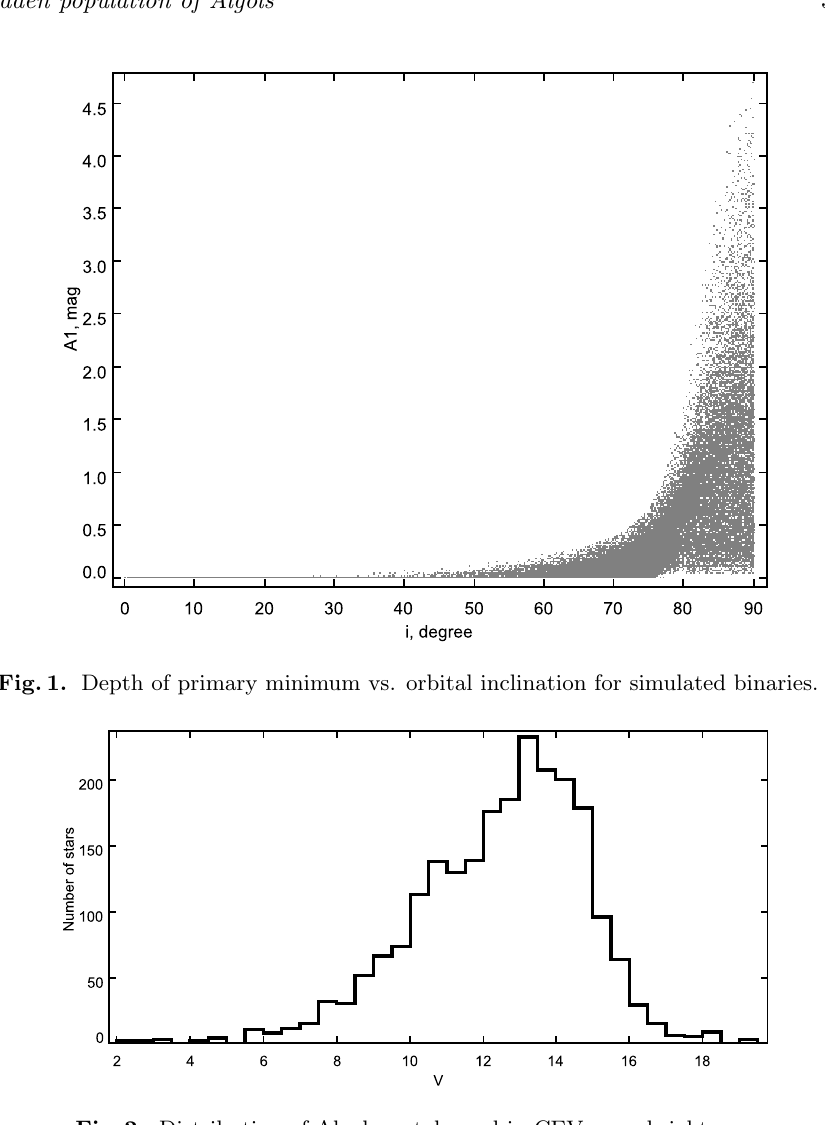
Fig. 2. Distribution of Algols, catalogued in CEV, over